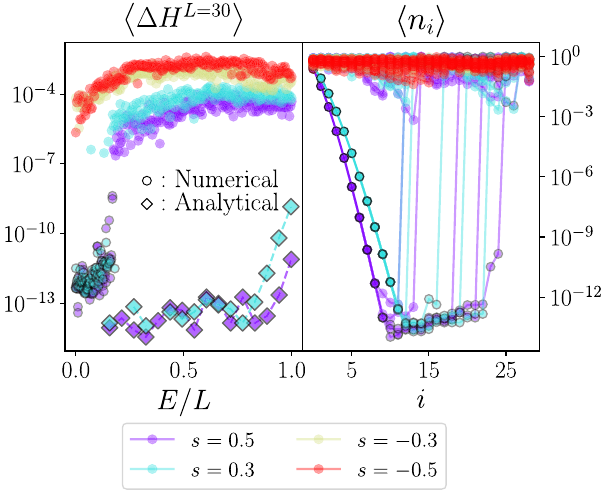
FIG. 5. Energy variance (left panel) and single-site occupation expectation (right panel) of MPS approximations ( D ¼ 50 ) to the excited states for L ¼ 30 sites. (Left panel) For small values of the energy densities and s > 0 , the MPS approximations are close to machine precision. The black edge indicates the MPS with variance below 10 − 8 . For such states (right panel), we observe that the spatial distribution of the single-site occupation corre- sponds to the profile of the analytical construction in Eq.